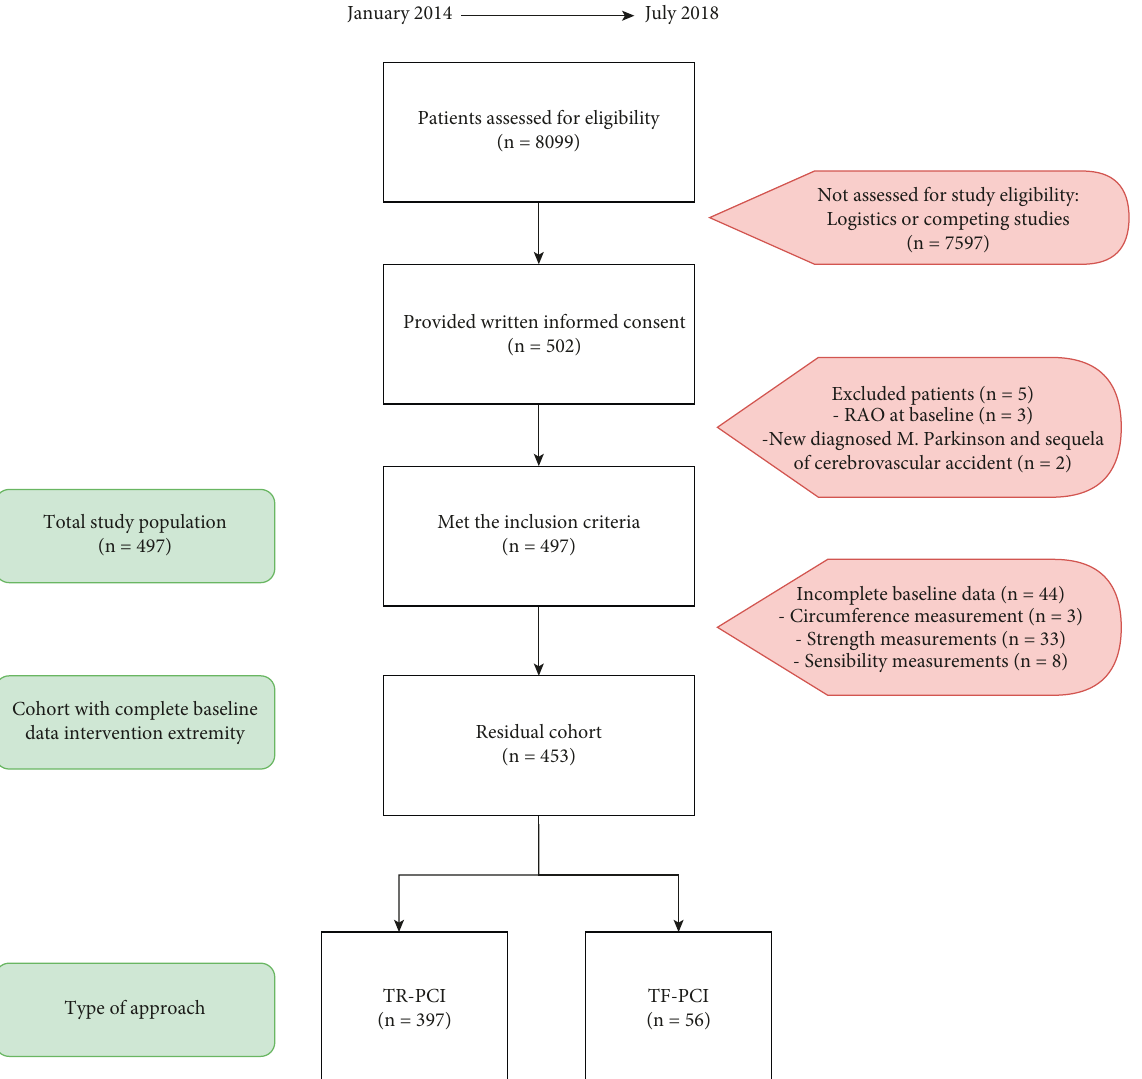
Figure 1: Flowchart study enrolment. RAO: radial artery occlusion, TR-PCI: transradial percutaneous coronary intervention, and TF-PCI: transfemoral percutaneous coronary